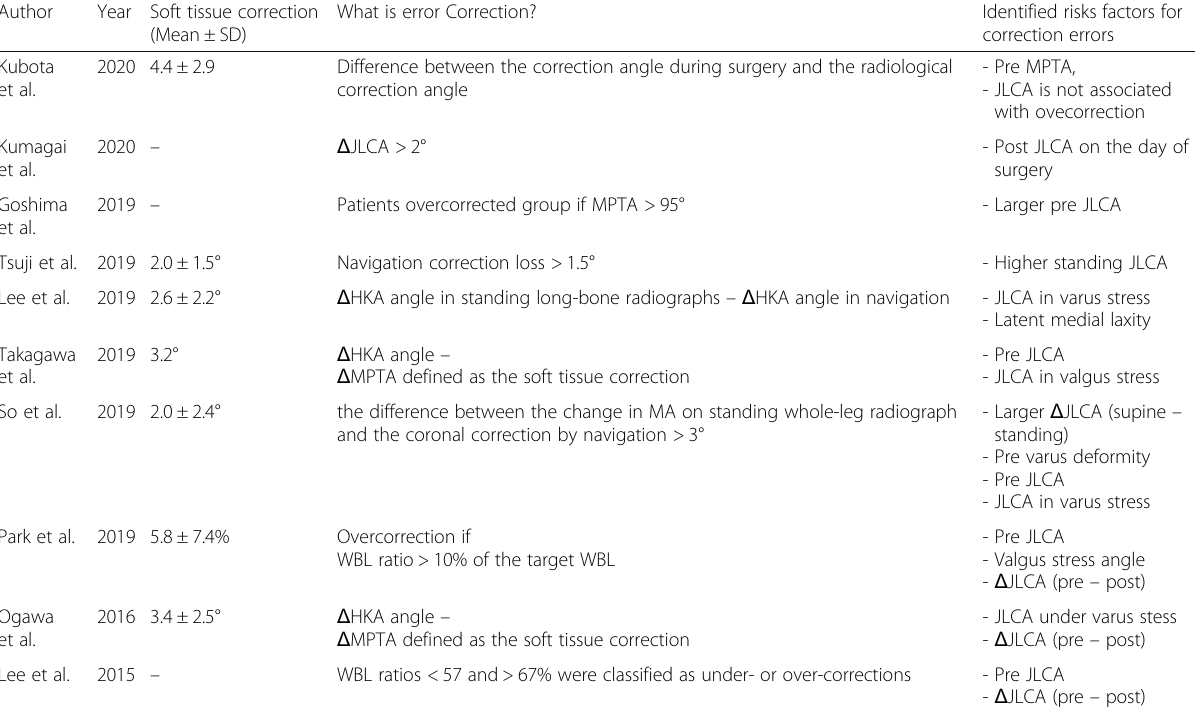
Table 2 Summary of JLCA influence on osteotomy